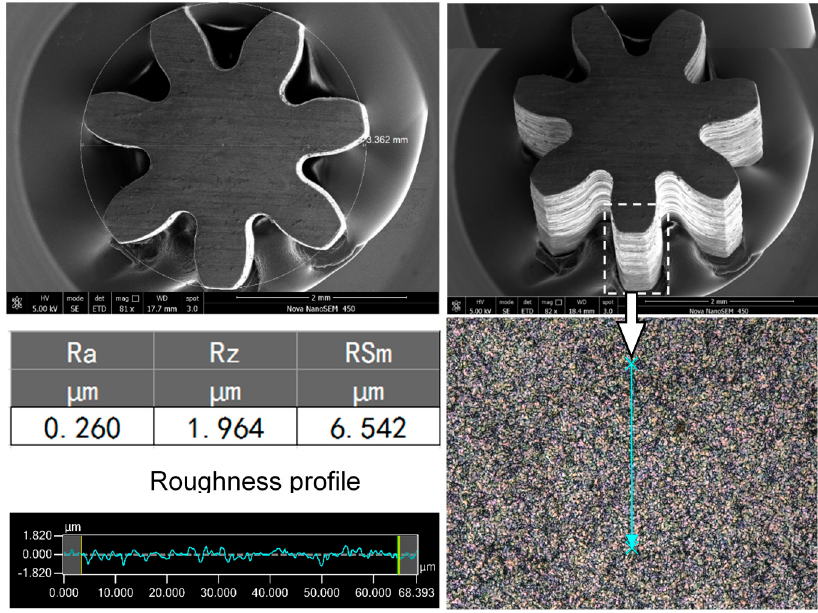
Figure 22. Micro gear with a high aspect ratio.